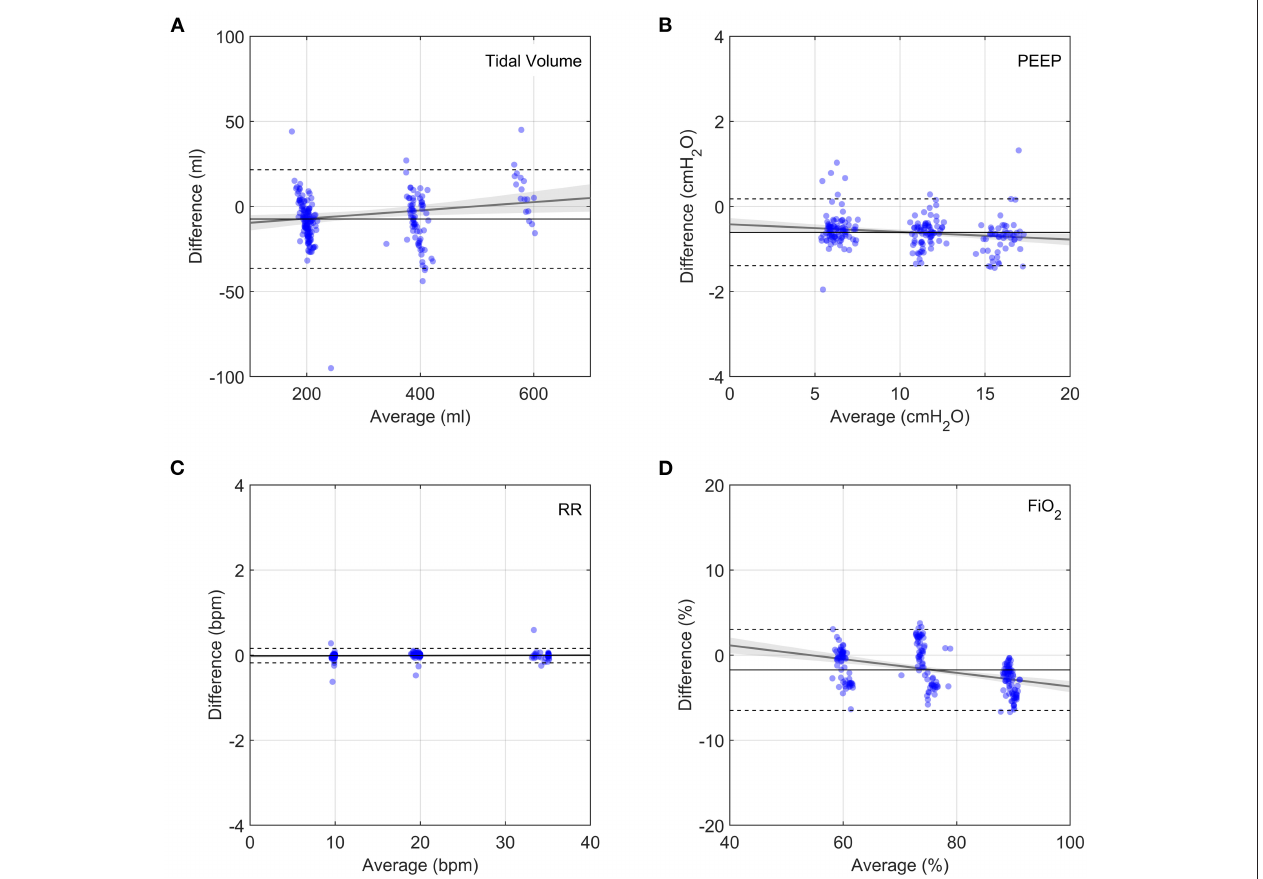
FIGURE 5 | Bland-Altman plots of output parameters between the prototype and the flow analyser. Each data point represents the average of 9 breaths, taken 5 breaths after changing a single clinical input. Grey lines show linear fits to the data with the 95% confidence bands indicated by the shaded grey regions. Horizontal solid lines show average difference and dashed lines show plus and minus two standard deviations. (A) Tidal volume, (B) PEEP, (C) Respiratory Rate, (D) FiO 2